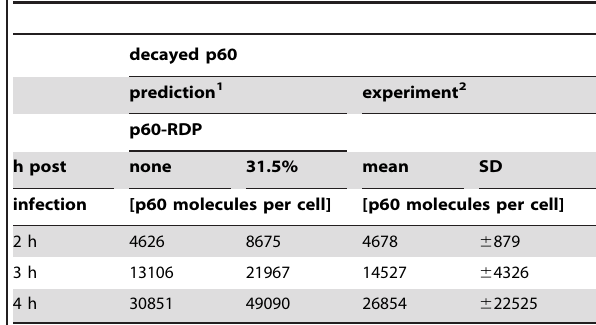
Table 2. Stoichiometry of p60 in L. monocytogens -infected